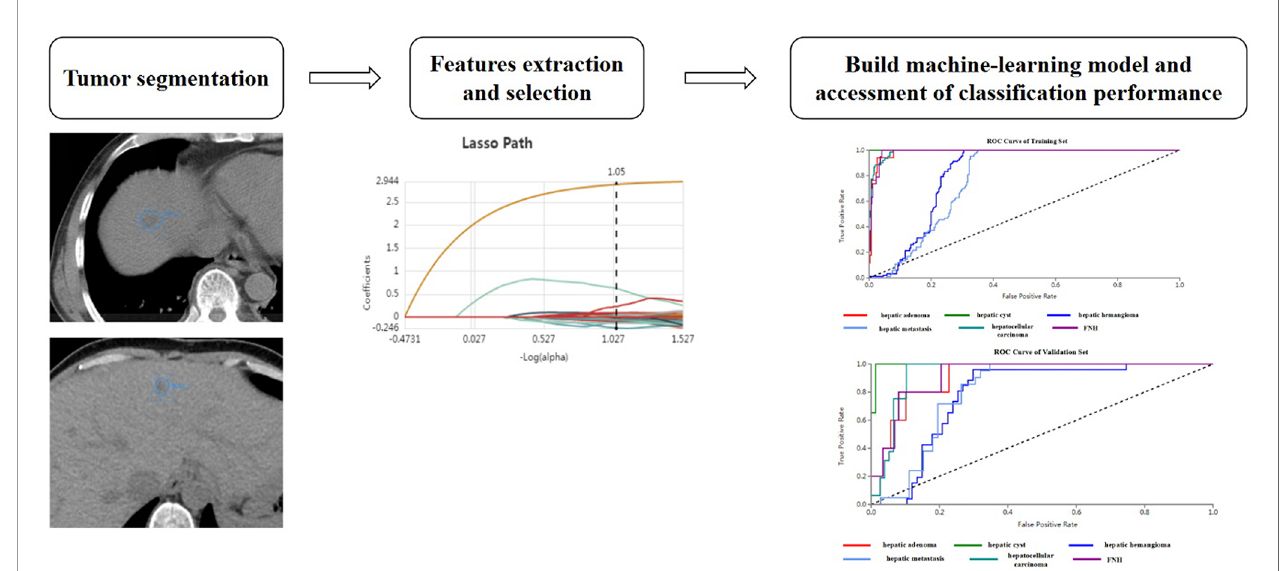
FIGURE 1 | Basic fl ow chart showing the radiomics method devised for the differential diagnosis of focal hepatic